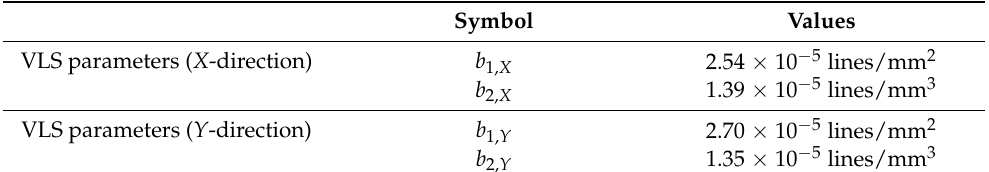
Table 1. Evaluated VLS parameters of the large-scale VLS grating. (One cross-section